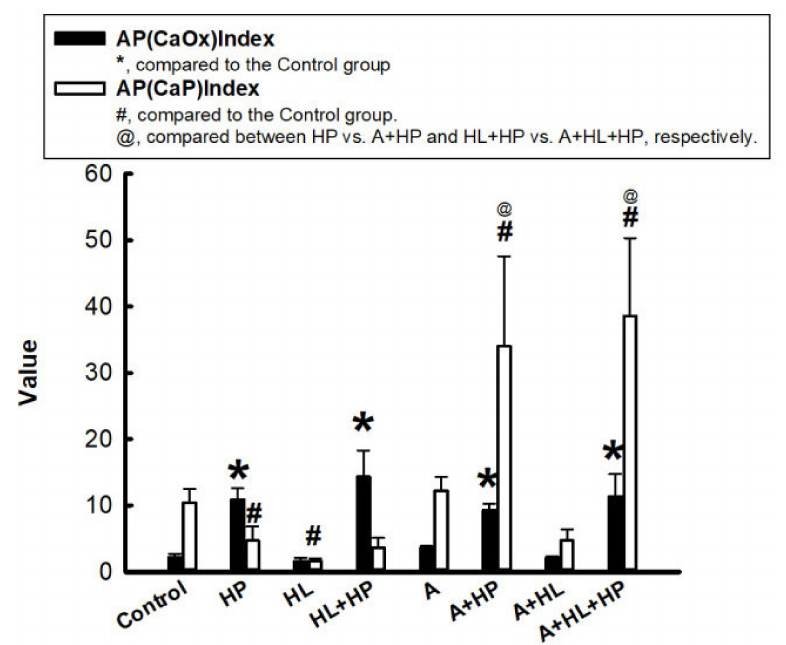
Figure 1. Ion activity product of calcium oxalate (AP(CaOx)) and calcium phosphate (AP(CaP)). The black bar represents AP(CaOx), and the white bar represents AP(CaP). * p < 0.05 versus AP(CaOx) of the control group; # p < 0.05 versus AP(CaP) of the control group; @ p < 0.05 between with and without A in each subgroup (e.g., N vs.